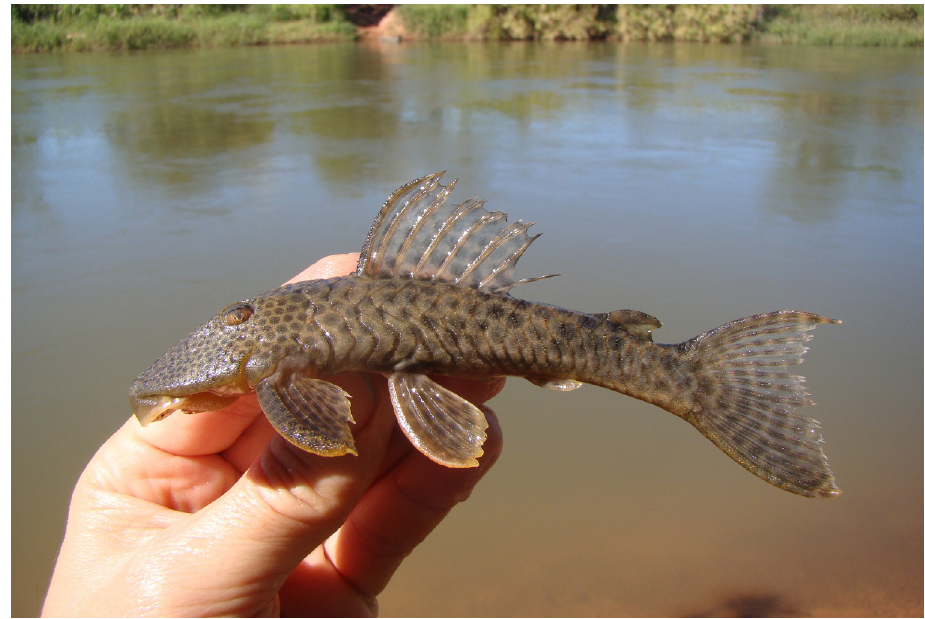
FIGURE 5 | Hypostomus velhomong e, color in life, UFPB 9566, paratype, 88.0 mm SL, with non-deposited material. Parnaíba River, Santa Filomena, Piauí,